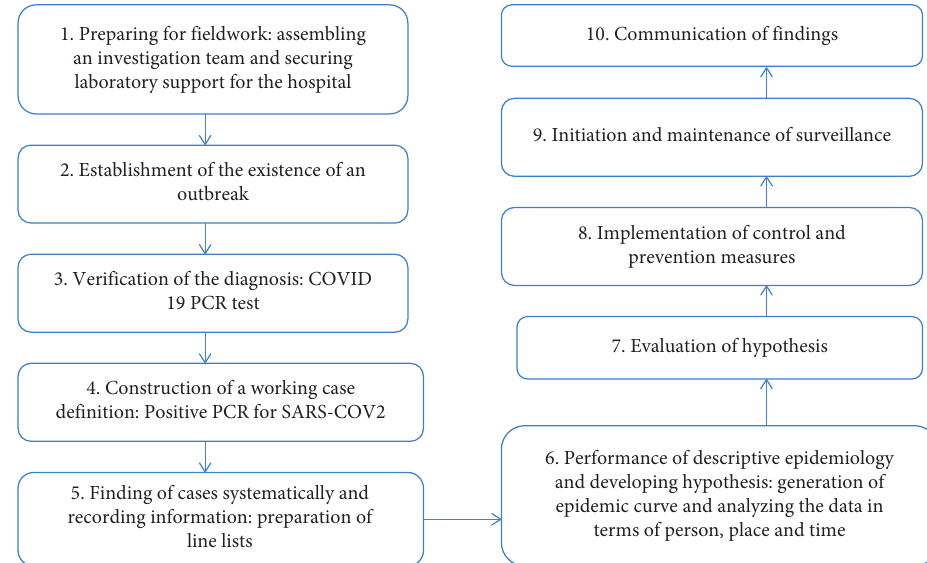
Figure 1: Steps of the outbreak Table 1: Characteristics of all participants ( n � 193).